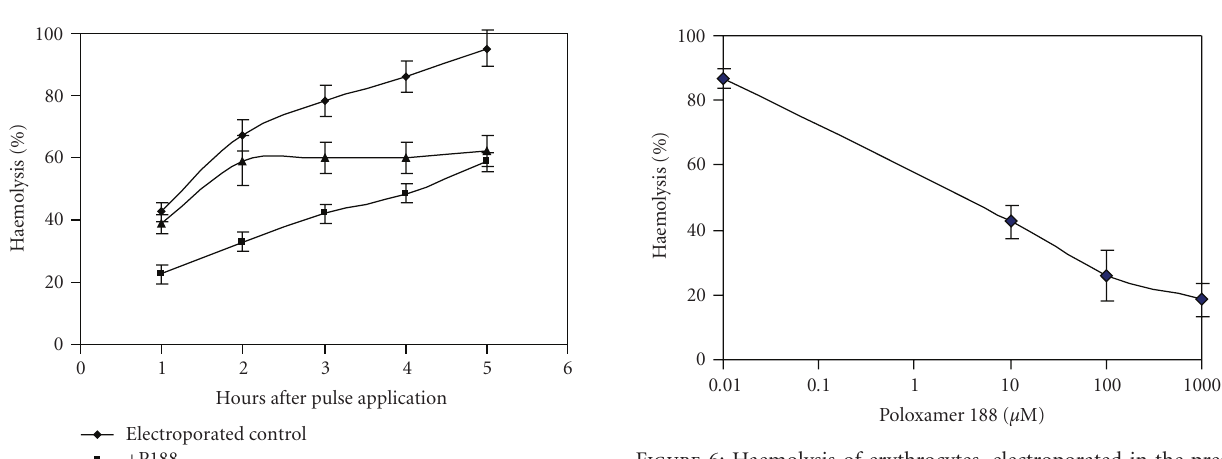
Figure 6: Haemolysis of erythrocytes, electroporated in the pres- ence of di ff erent concentrations ( μ M) of P188 after 3 hours. The electrical parameters were the same as in Figure 5. The abscissa is in logarithmic scale, the point 0.01 corresponds to the control (zero concentration of P188).